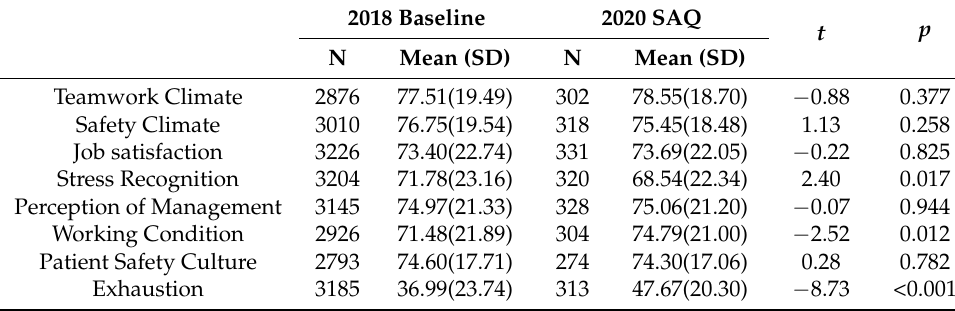
Table 2. Changes in patient safety culture and exhaustion, 2018 vs.